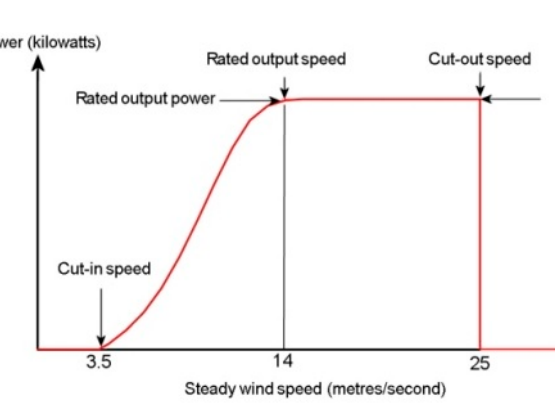
Figure 8. Wind power output with steady wind